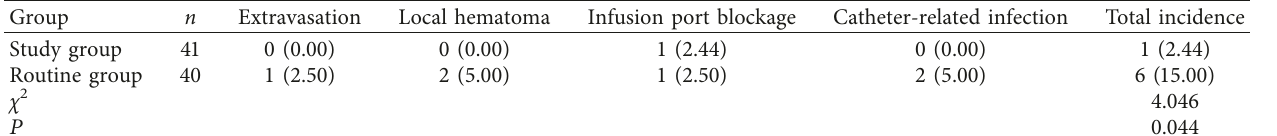
Note: Compared to before intervention, ∗ P < 0 . 05. Table 2: Comparison of the incidence of adverse events between the two groups [ n (%)].